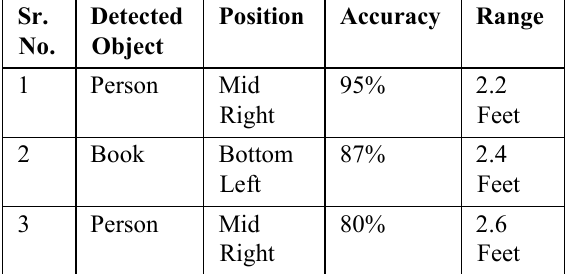
Figure 5. The output of YOLO algorithm for Frame-2.